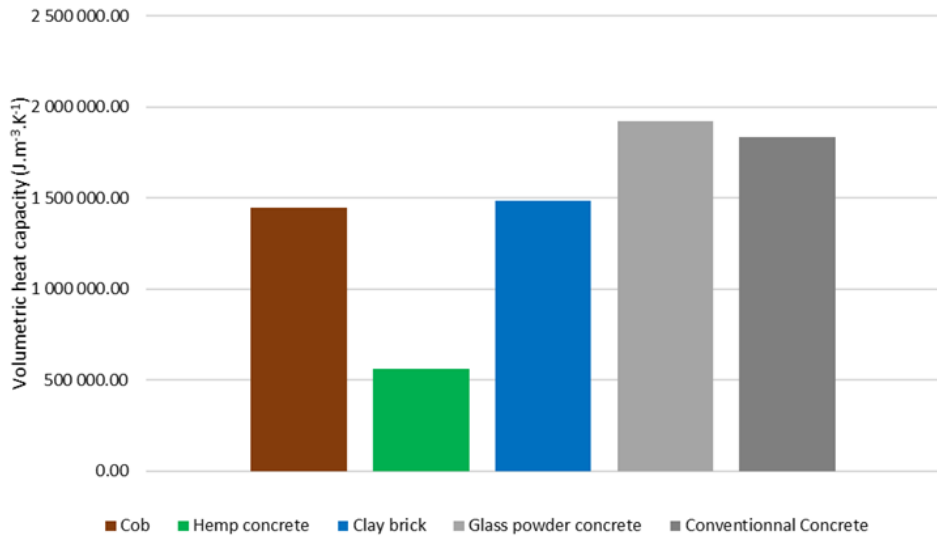
Figure 12. Sorption isotherms of raw earth (RE), raw earth/straw composite (RES) ( a ) and straw (S) ( b ); the lower curve for each formulation corresponds to the adsorption isotherm, while the upper curve corresponds to the desorption isotherm. As can be observed in Figure 12a, the evolution of water content as a function of the relative humidity is showed. It appears that the water content ( w ) is less significant in the raw earth specimens (RE) compared to the raw earth/straw composite (RES). An increase of about 18% in the maximum water content was noticed in the saturation region after the incorporation of straw in raw earth. This is due to the adsorption capacity of the straw plant (25%), which is one of highest (Figure 12b). By comparing these results with those of other materials (Figure 13a), it is noticed that the glass power and reference concrete have the highest values of water content, that reach 117 and 93 kg·m −3 , respectively. Hemp concrete and RES have similar values (between 60 and 80 kg·m −3 ). In order to better ana- lyze the hygroscopic behavior of the materials, moisture content is plotted in terms of